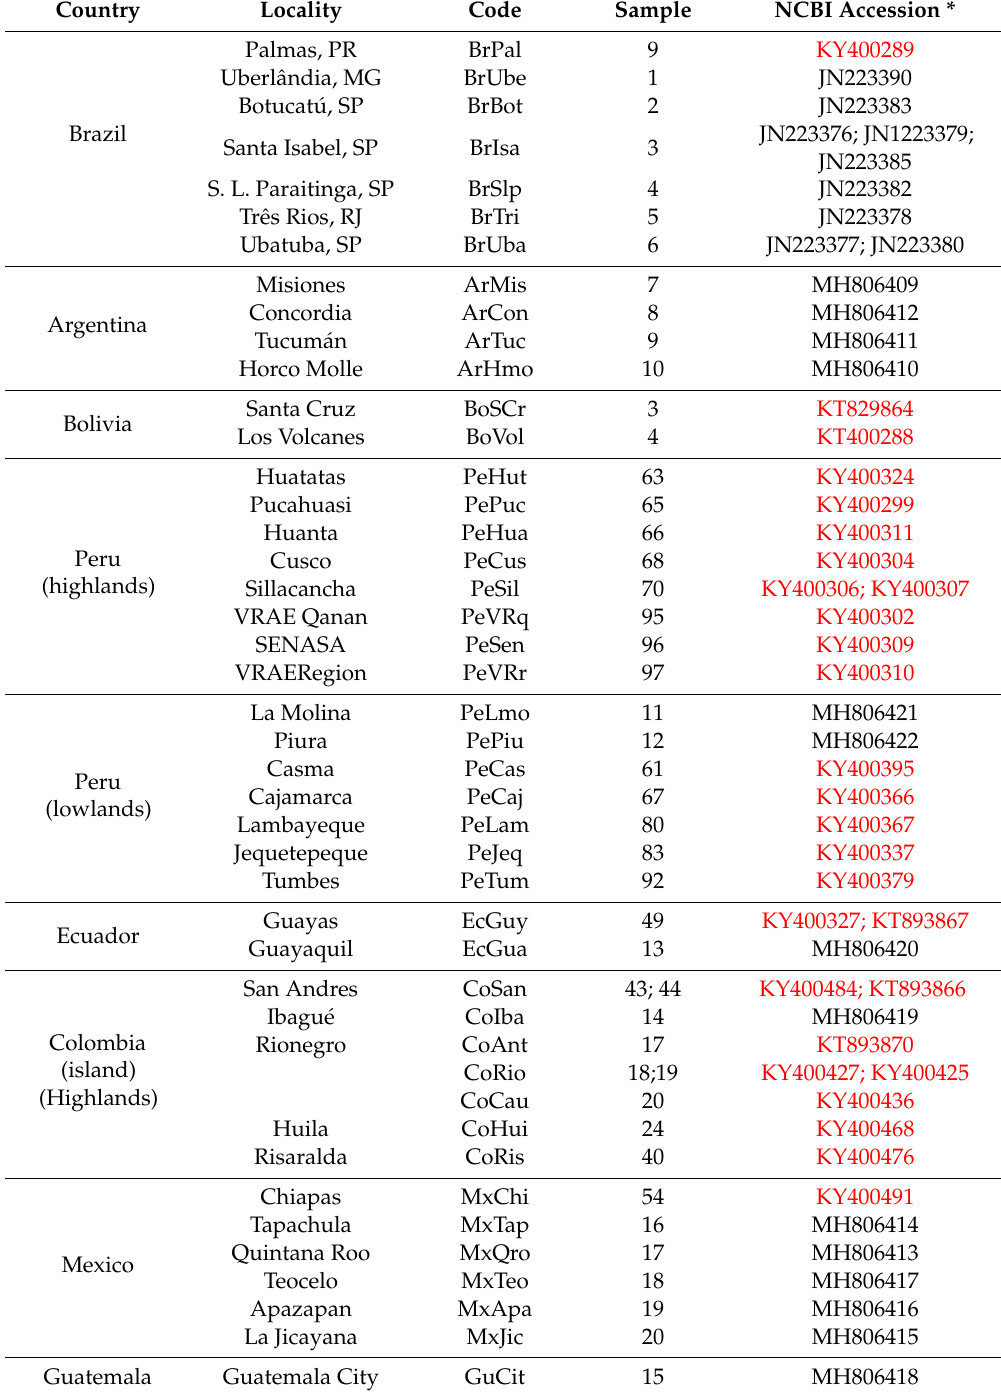
Table 2. Country, locality, code, sample and NCBI accession of ITS1 sequences of the AF complex.